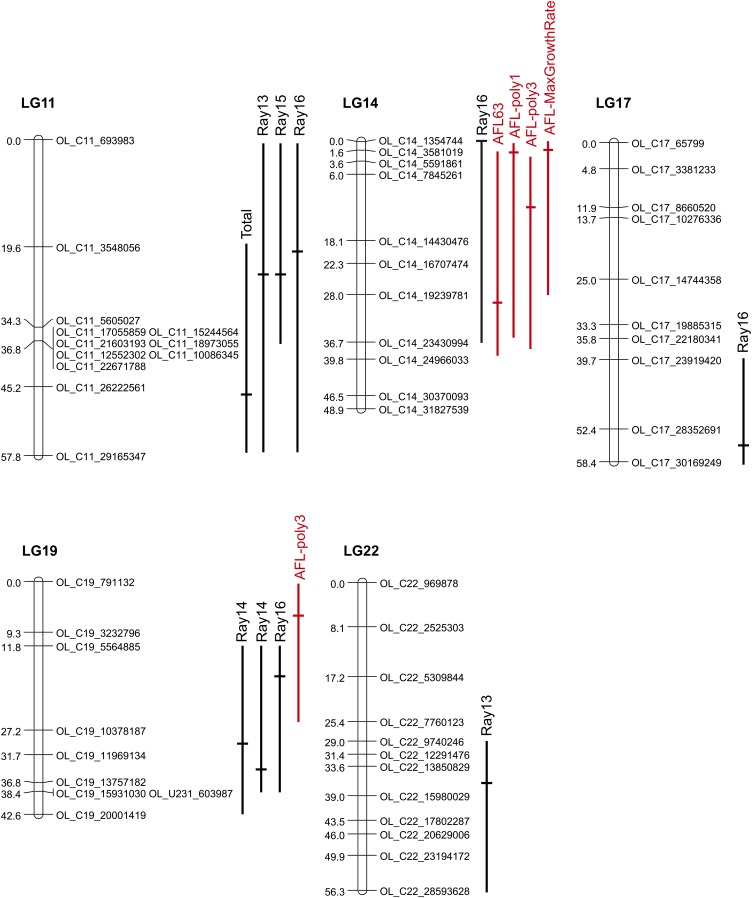
Significant quantitative trait loci (QTL) and 95% Bayesian credible intervals mapped on the linkage groups (LGs) of the OFAM family. Only LGs with significant QTL are shown here. Black and red lines indicate QTL for papillary processes and anal fin length, respectively.